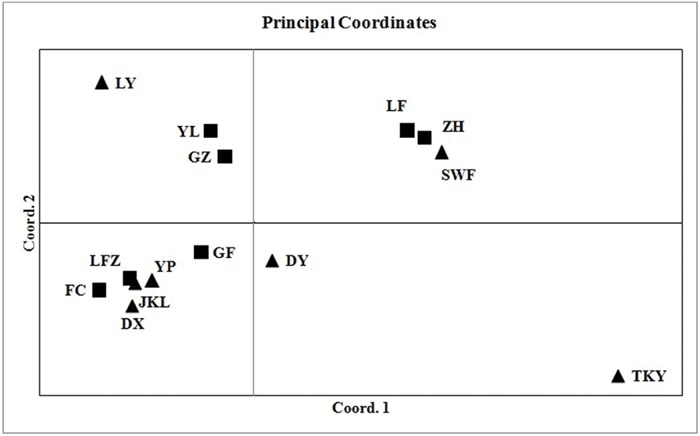
Principal coordinates analysis illustrating genetic differences among 14 populations of C. communis. Coordinate 1 is accounted for 42.57% and coordinate 2 for 28.77% of the total variation among populations. The abbreviations of population name are same as Table 1.